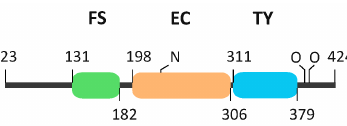
Figure 1. Schematic representation of testican-2 domain architecture. Full-length testican-2 is composed of N- and C-terminal regions surrounding the three central domains: follistatin (FS, green), calcium-binding (EC, orange) and thyroglobulin (TY, blue). Labels N and O mark N- and O-glycosylation sites, respectively. The scheme depicts mature testican-2 without signal peptide, numbering refers to interdomain boundaries.